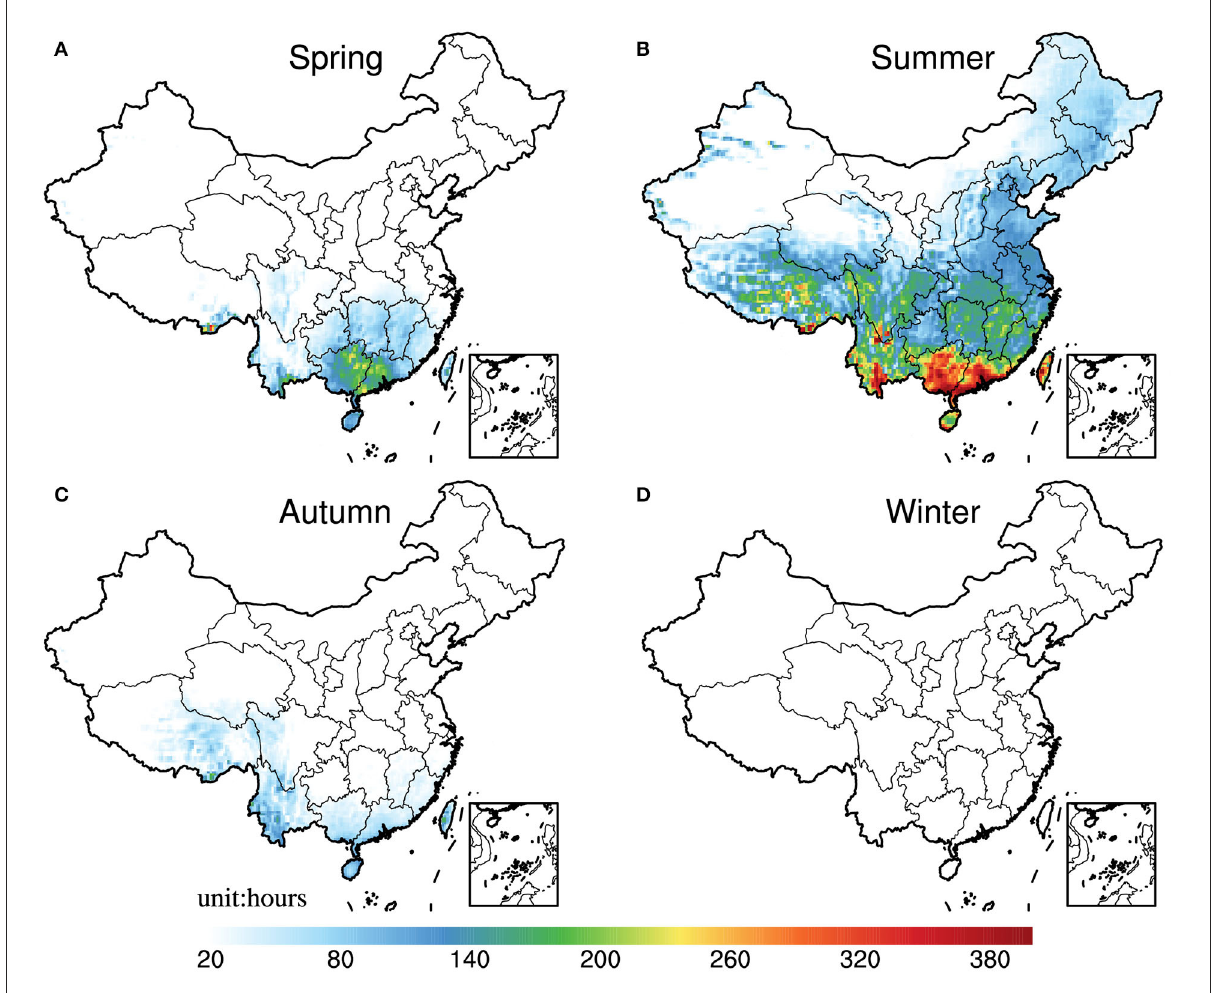
FIGURE4 (A-D) Same as Figure 2, but for seasonal mean